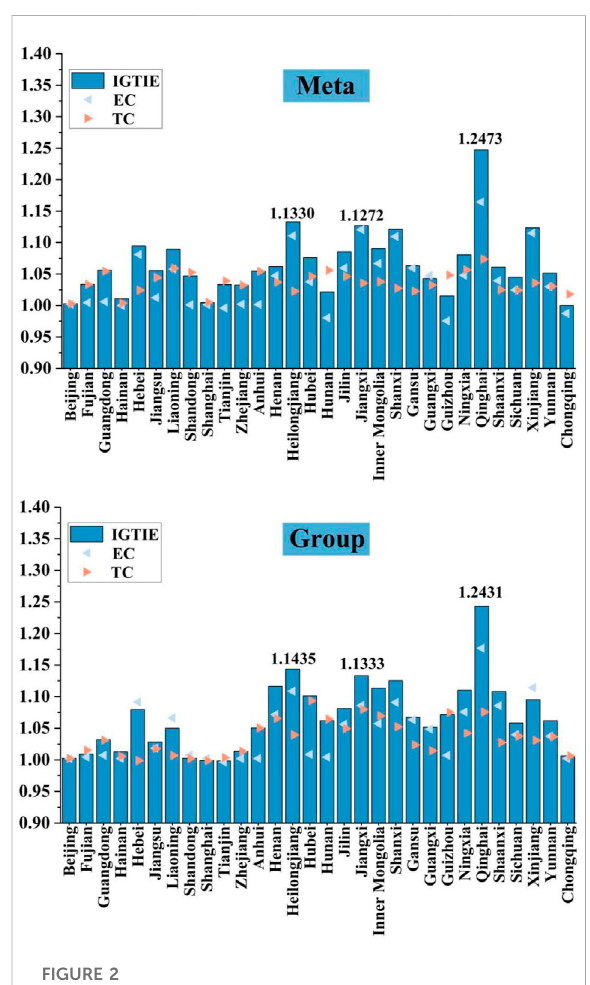
FIGURE 2 IGTIE and its decomposition target in different